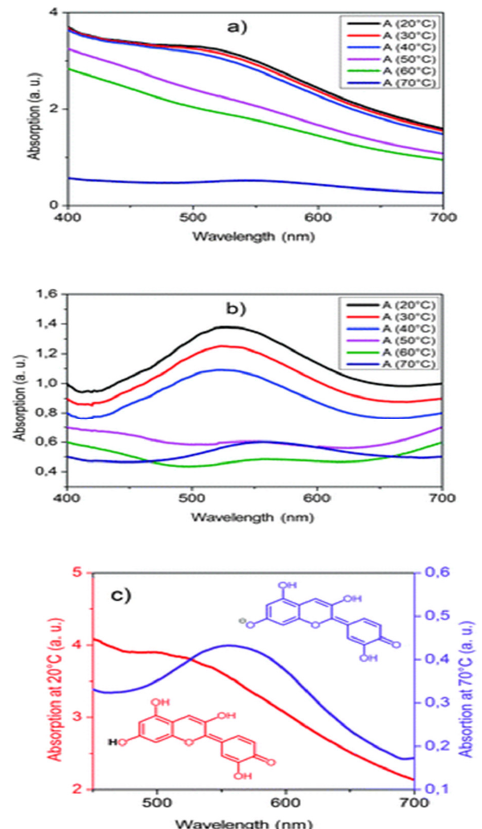
Figure 12. Temperature dependency of the visible absorption of PLA composite: ( a ) original curves on heating, ( b ) slope corrected curves on heating and ( c ) thermochromic switching effect, red curve: cold state, violet curve: hot state. Reproduced with the permission of Reference [38]. Copyright The Royal Society of Chemistry.